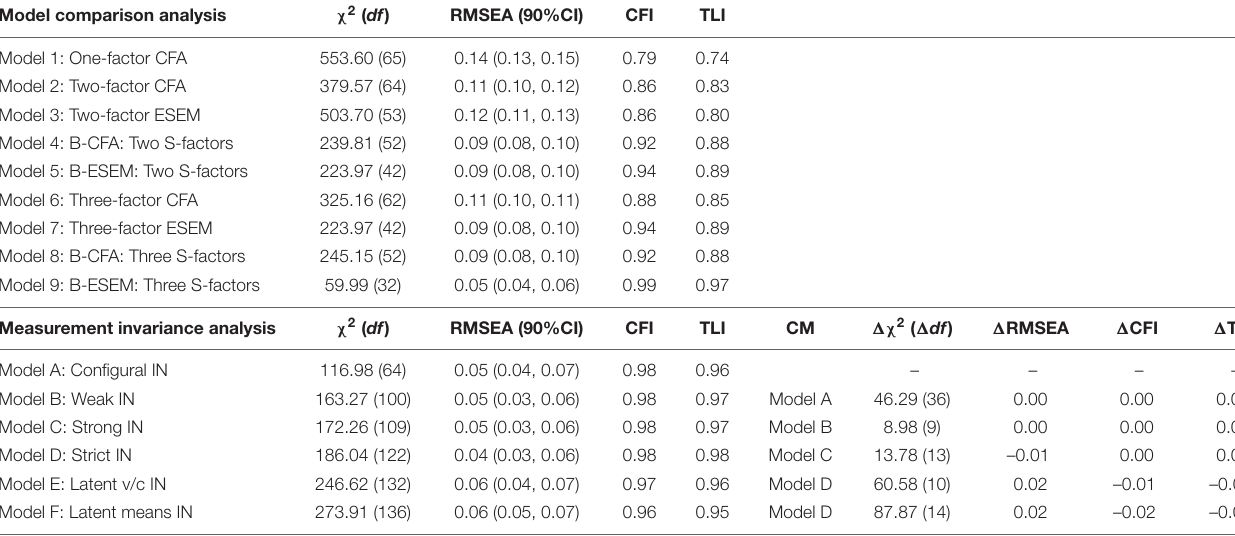
TABLE 2 | Model fit statistics of alternative measurement models (upper) and measurement invariance tests of B-ESEM model (lower). Model comparison analysis χ 2 ( df )